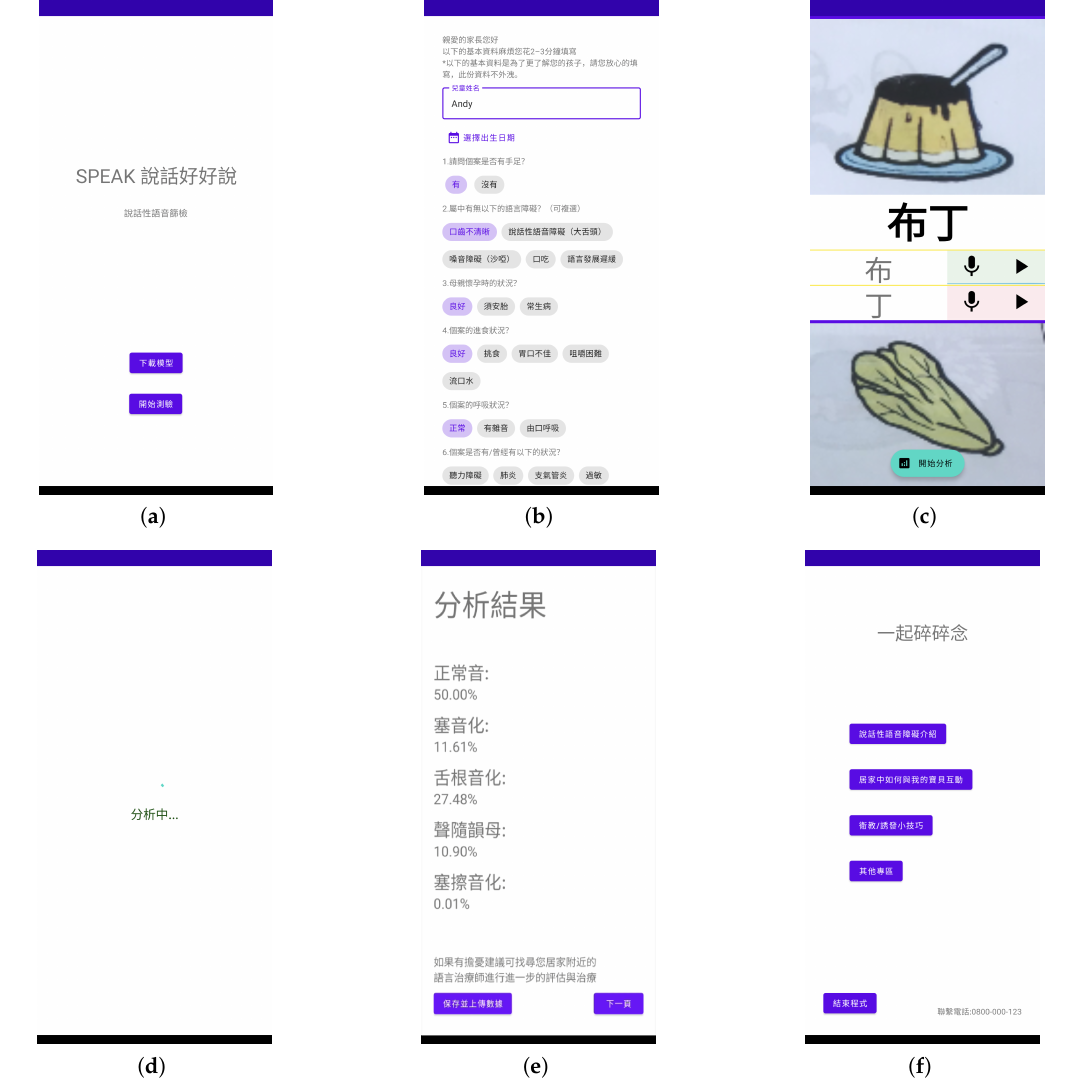
Figure A1. Screenshot of the mobile application: ( a ) Application main page: Users have the option of initiating a test or downloading the most recent classification model.; ( b ) User questionnaire